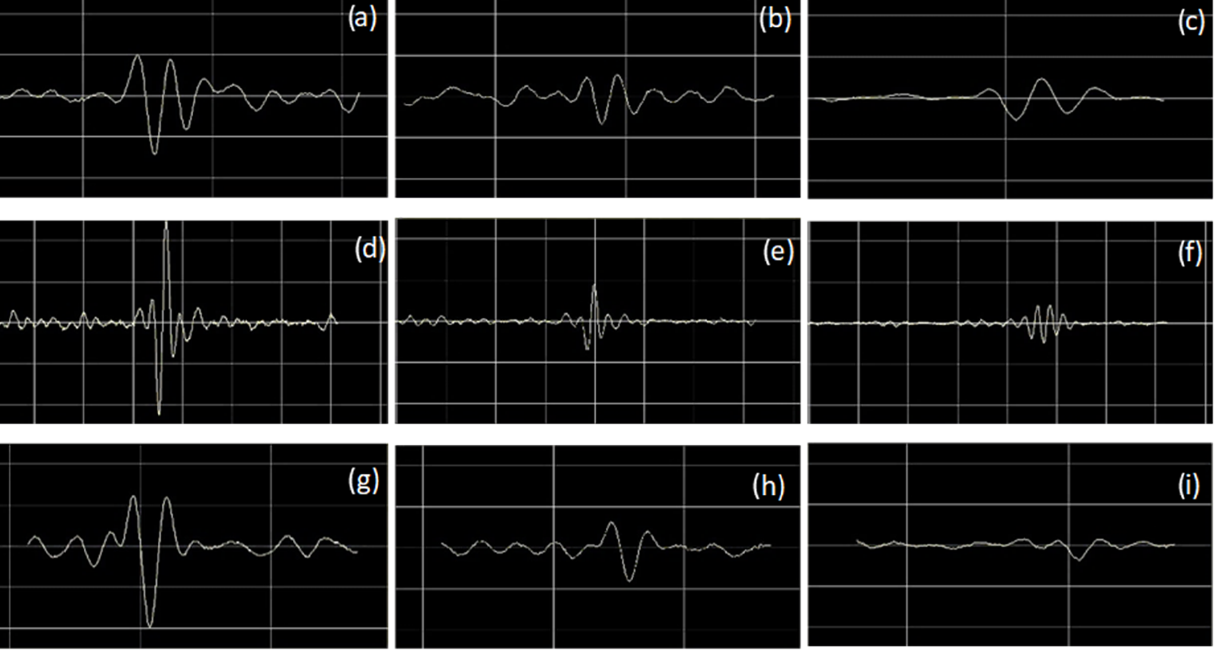
Figure 7. A-Scans obtained for: ( a ) weld root notch at 18 °C, ( b ) weld root notch at 122 °C, ( c ) weld root notch at 200 °C, ( d ) weld toe notch at 18 °C, ( e ) weld toe notch at 120 °C, ( f ) weld toe notch at 203 °C, ( g ) lack of fusion at 18 °C, ( h ) lack of fusion at 120 °C, and ( i ) lack of fusion at 201 °C.